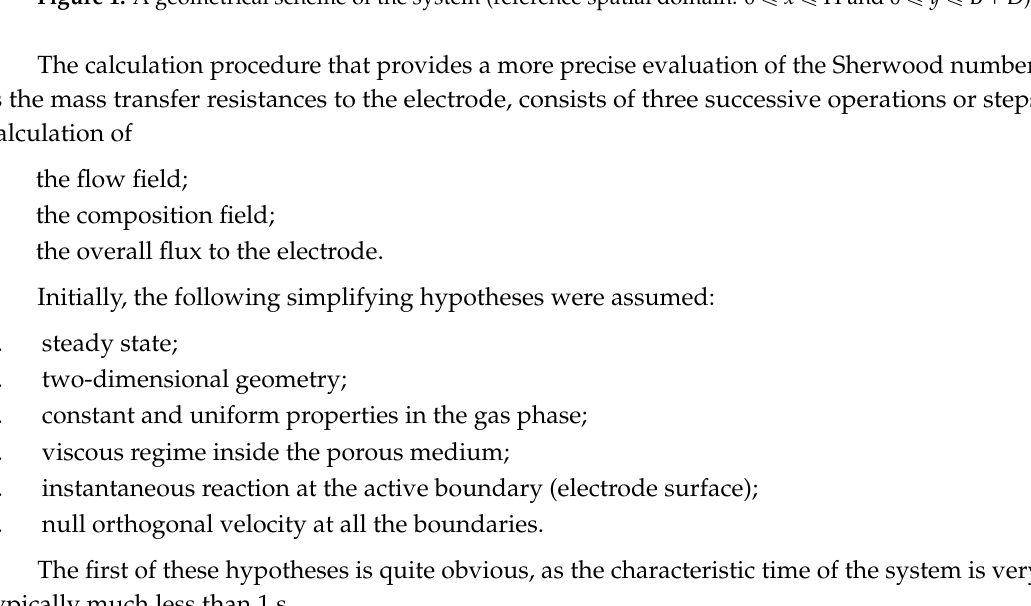
Figure 1. A geometrical scheme of the system (reference spatial domain: 0 ≤ x ≤ H and 0 ≤ y ≤ B + D).